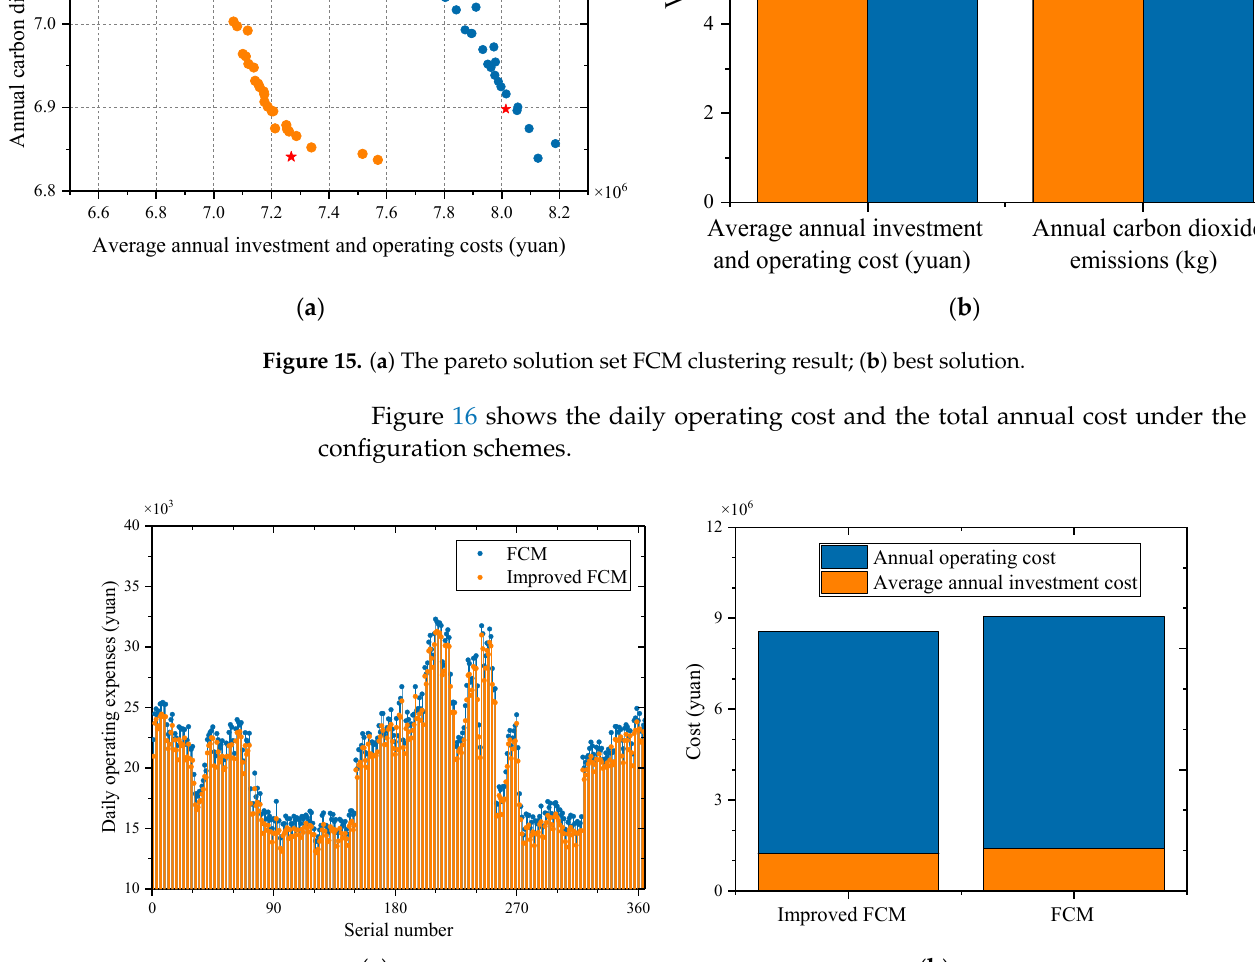
with a drop rate of 4.68%. The average annual investment cost dropped by 140,090 yuan, of